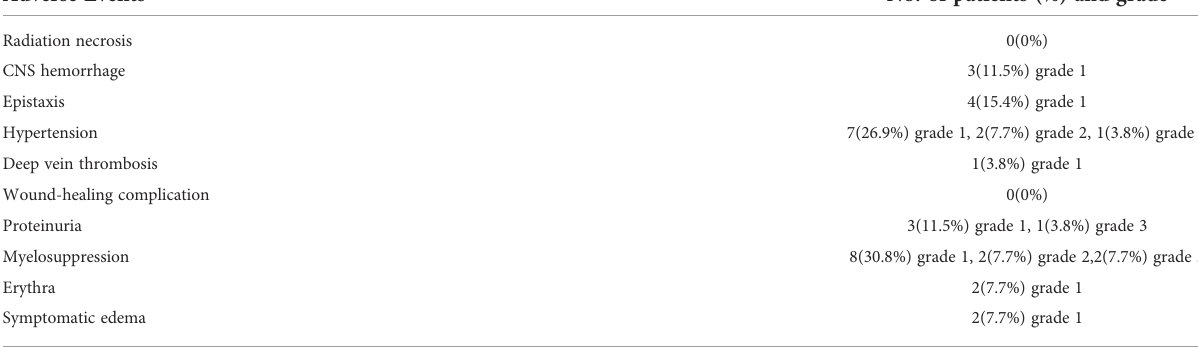
TABLE 2 Safety pro fi le of re-irradiation combined with bevacizumab ( N = 26), according to CTCAE version 5.0. Adverse